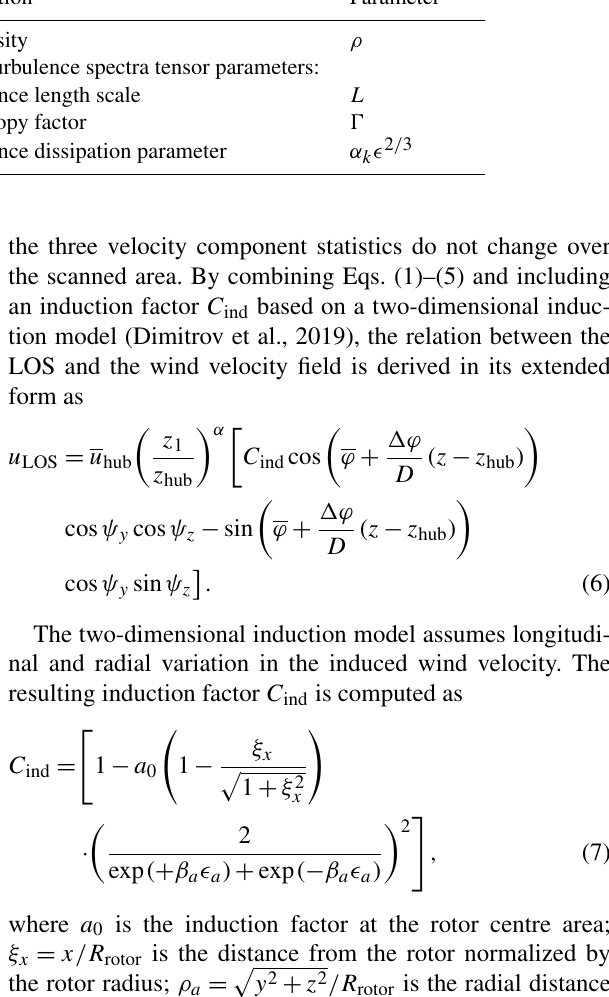
Table 1. Wind field parameters serving as input for aeroelastic load simulations.